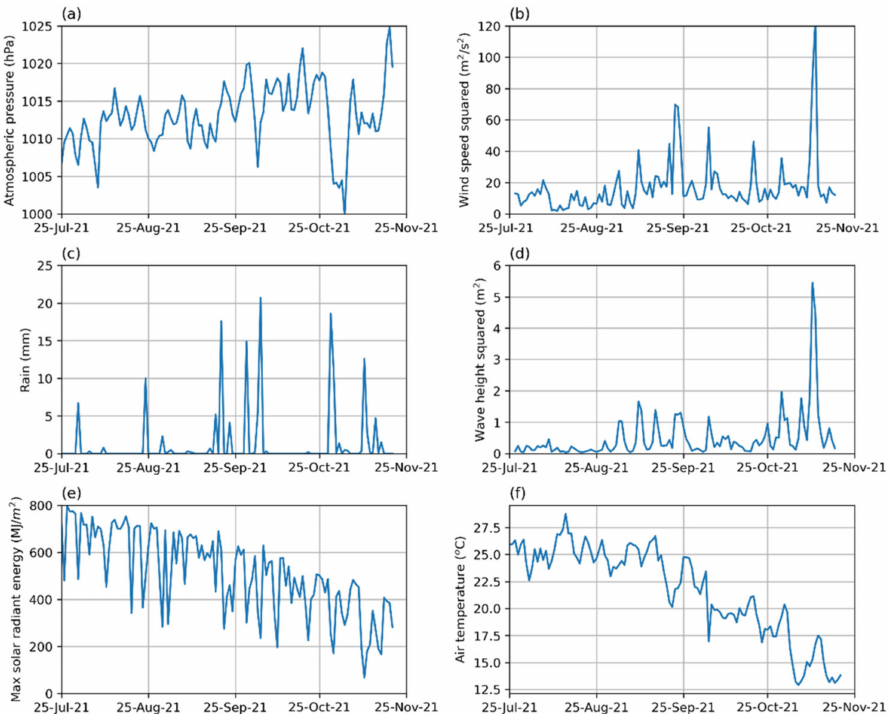
Figure 9. ( a ) Atmospheric pressure, ( b ) squared surface wind, ( c ) accumulated daily rainfall, ( d ) squared significant-wave height, ( e ) maximum daily solar radiation, and ( f ) surface air